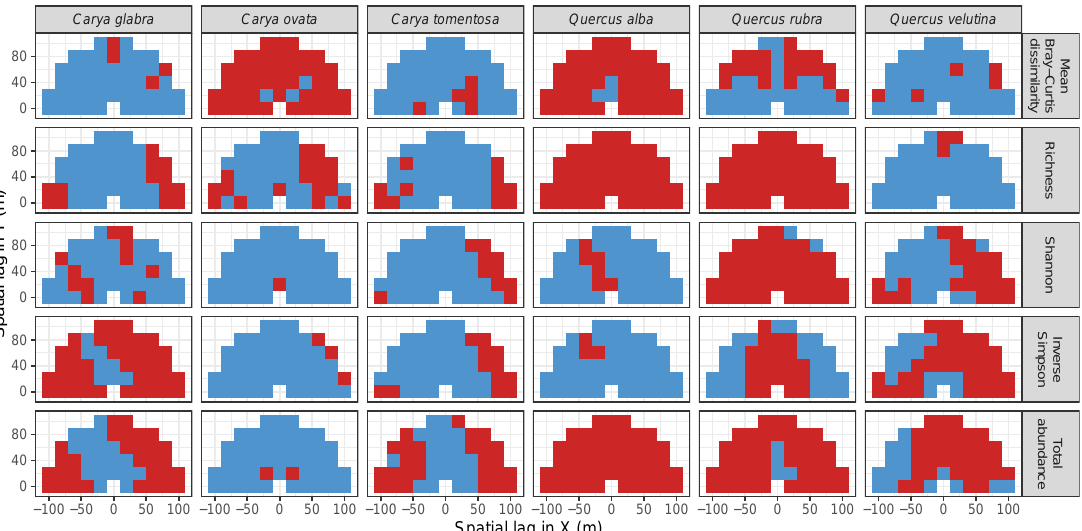
Figure A2. Statistical significance (red: P ≤ 0.05; blue: P > 0.05) of the codispersion coefficients calculated between measures of diversity and total basal area of the six focal tree species in 20 20-m × subplots in the 20-ha Tyson Research Center plot (Figure 13). Statistical significance was determined by comparing observed codispersion at each spatial lag with a distribution of 199 spatial randomizations of a CSR null model.